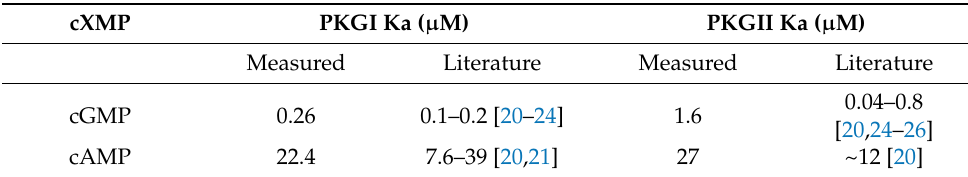
Table 1. Comparison of experimentally determined Ka values of cGMP and cAMP for PKGI and PKGII with literature